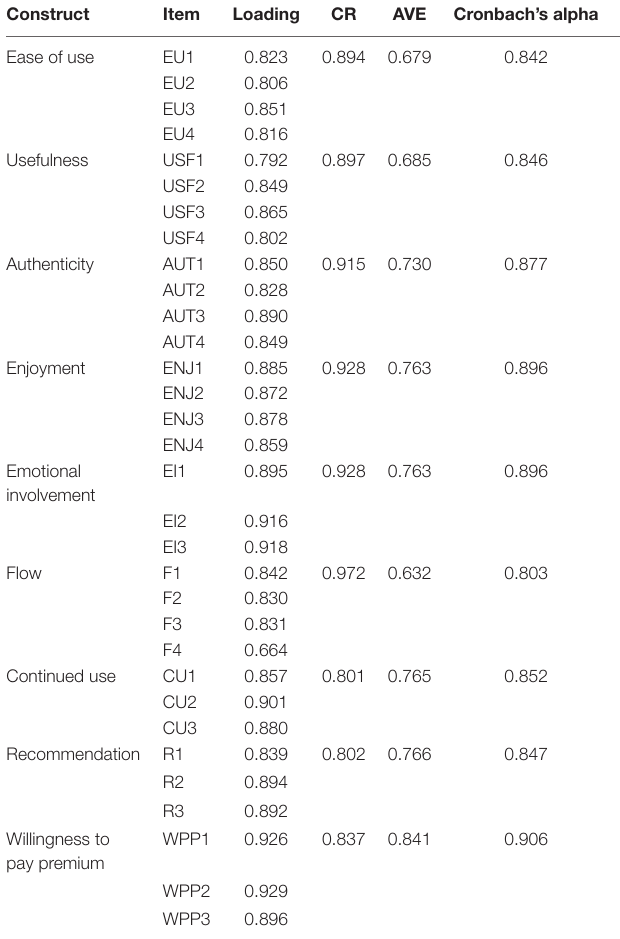
TABLE 3 | Reliability testing and convergent validity.